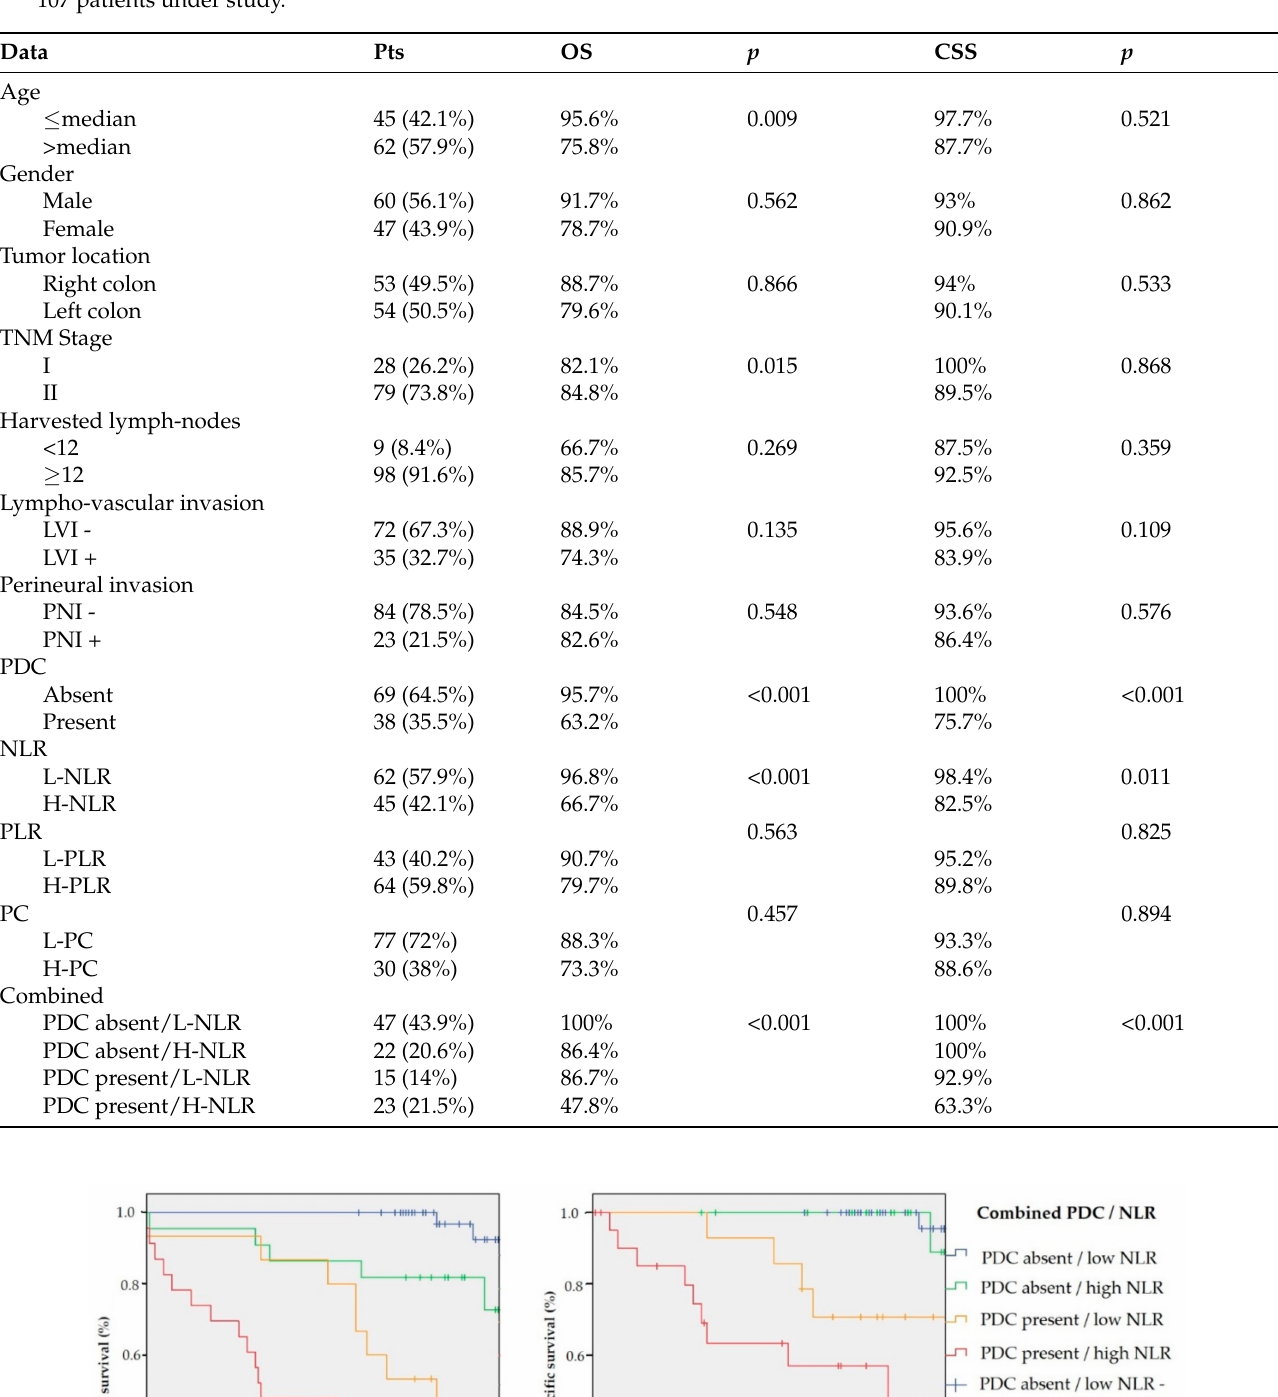
Table 2. Kaplan–Meier estimates of survival probability at 5 years according to main clinical–pathological variables for the 107 patients under study.